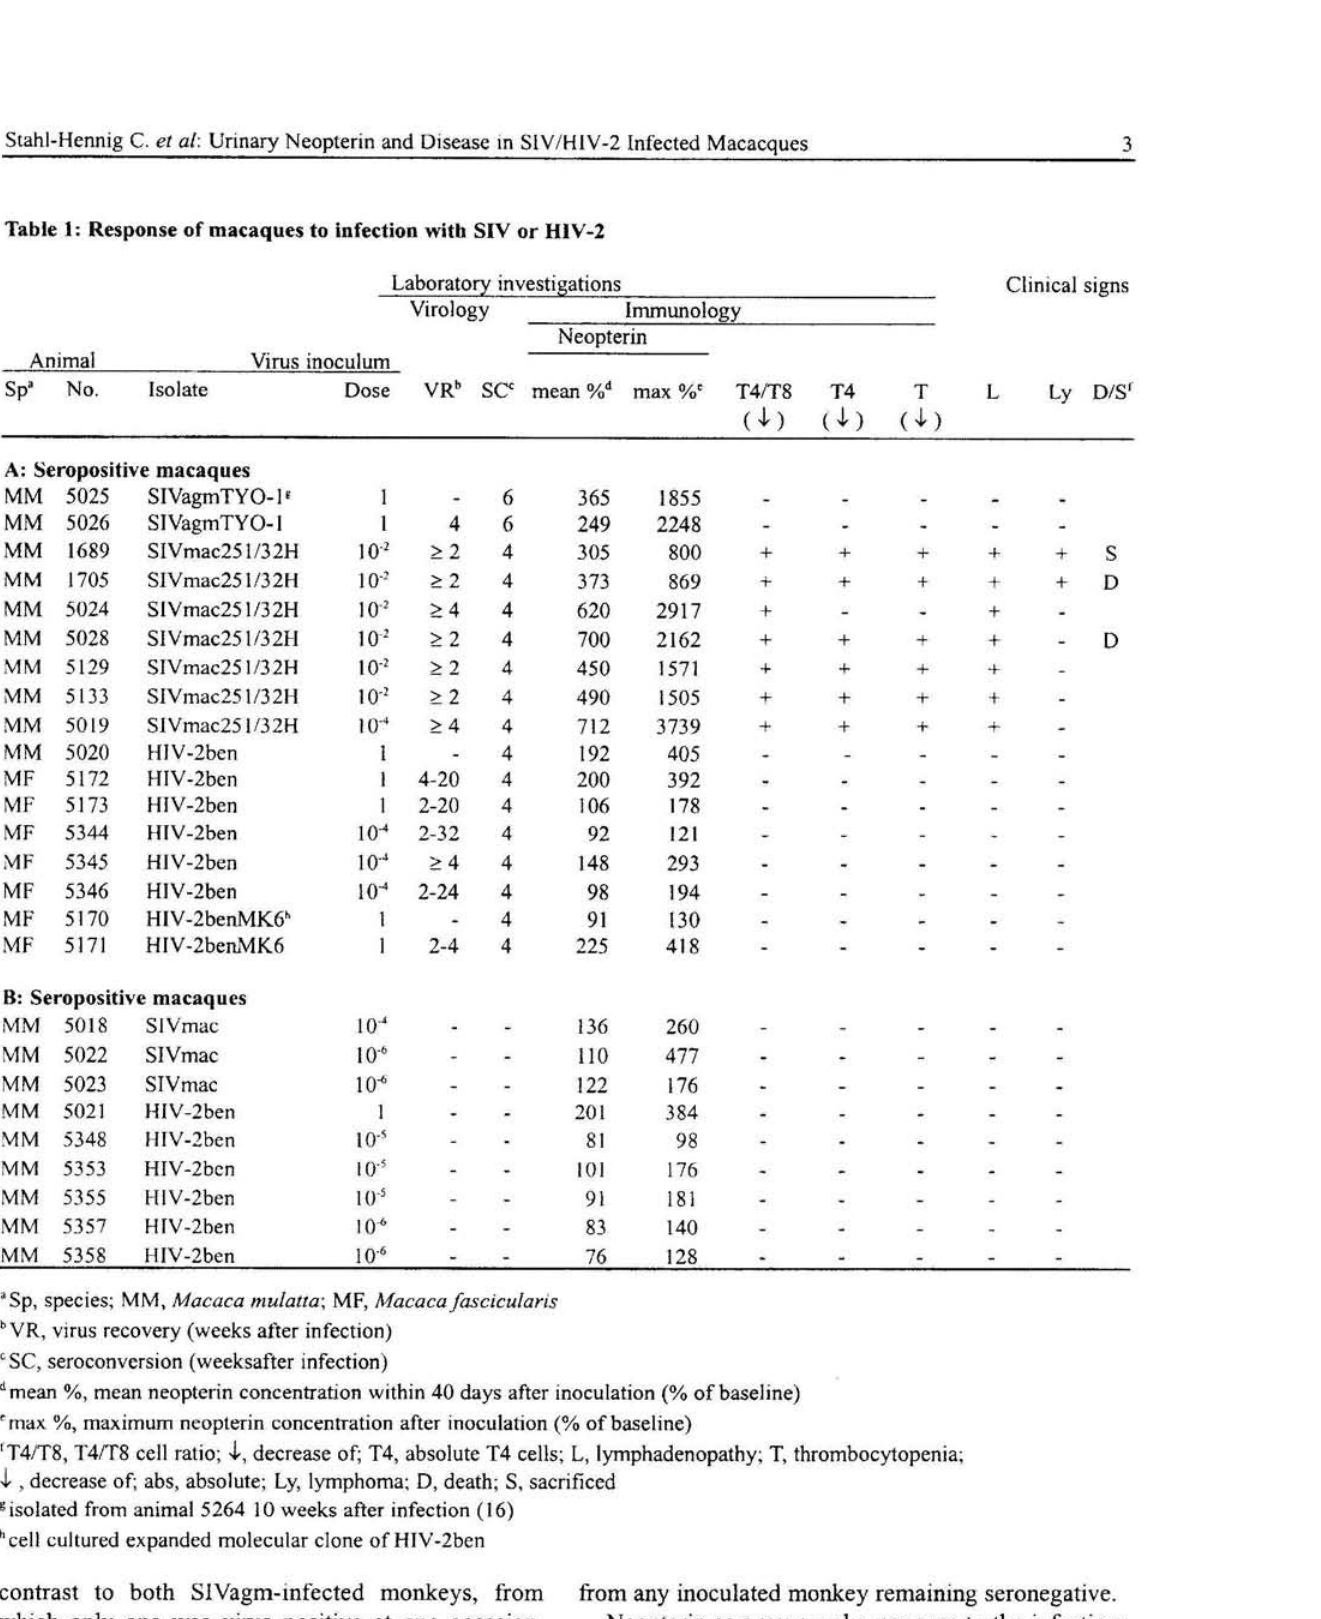
Table 1: Response of macaques to infection with SIV or HIV-2 Laboratory